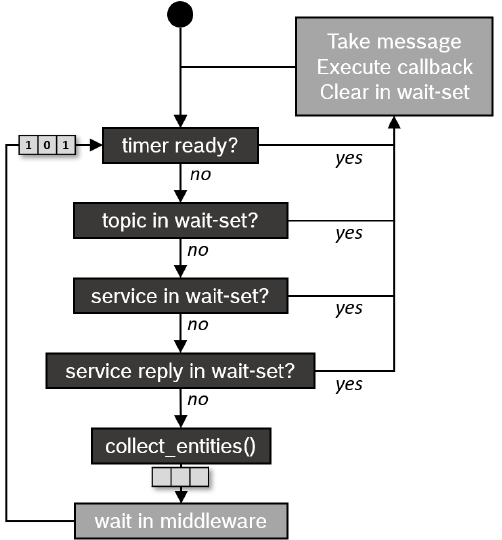
Figure 3. Scheduling semantics in ROS-2 (source: